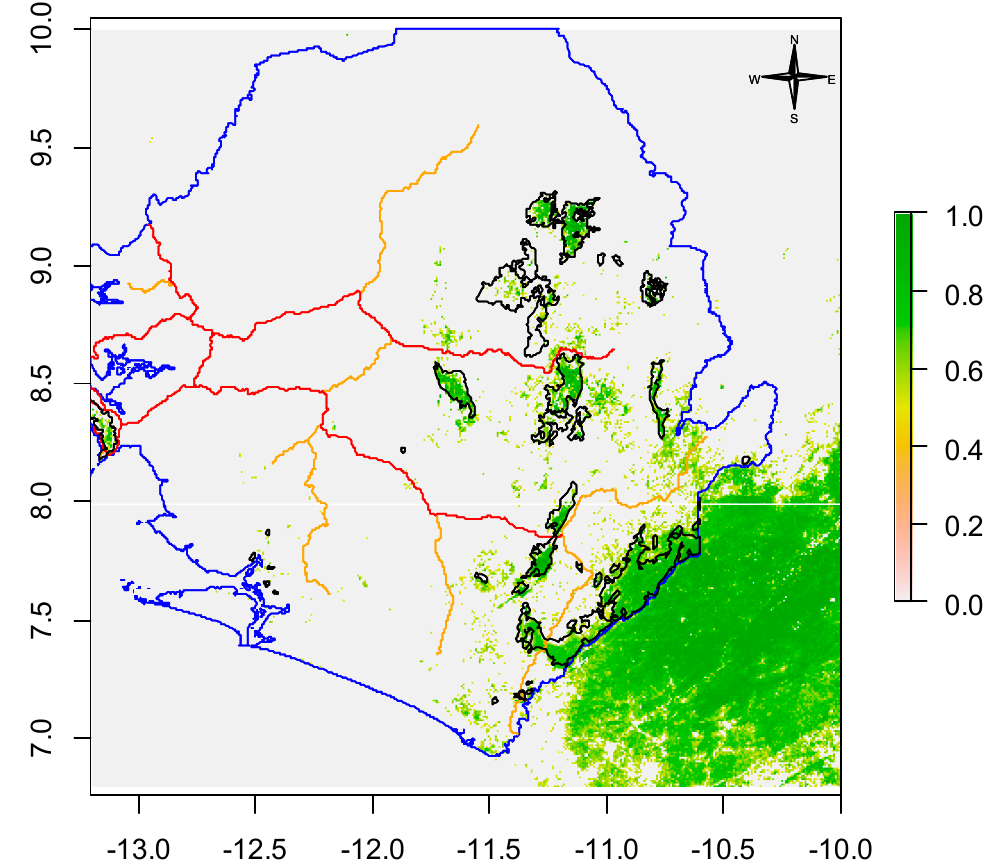
Figure 7. A comparison of “forest” cover in 2000 [30] shown with the black outline, and processed from Reference [26] as green infill (see text for details).